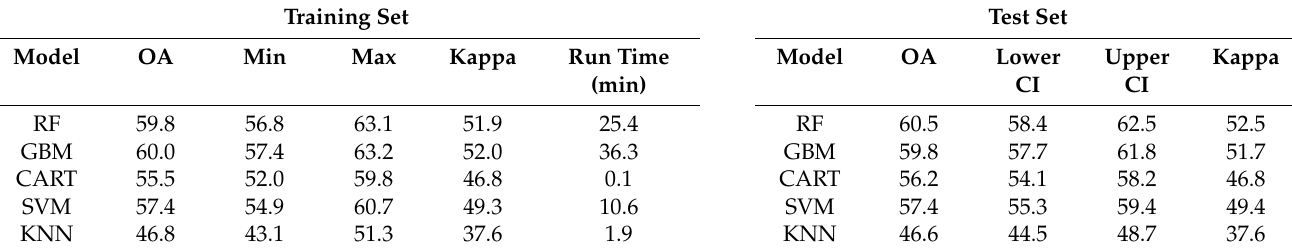
Table 1. Performance of the five machine learning classification models compared across the training and test data sets. Overall accuracy (OA) and Kappa are shown for each data set. Minimum and maximum accuracy values are reported for the training data set, while 95% confidence intervals (CI) are reported for the test data set. The five models were as follows: random forest = RF; stochastic gradient boosting = GBM; classification and regression tree = CART; support vector machine = SVM; and k-nearest neighbor =